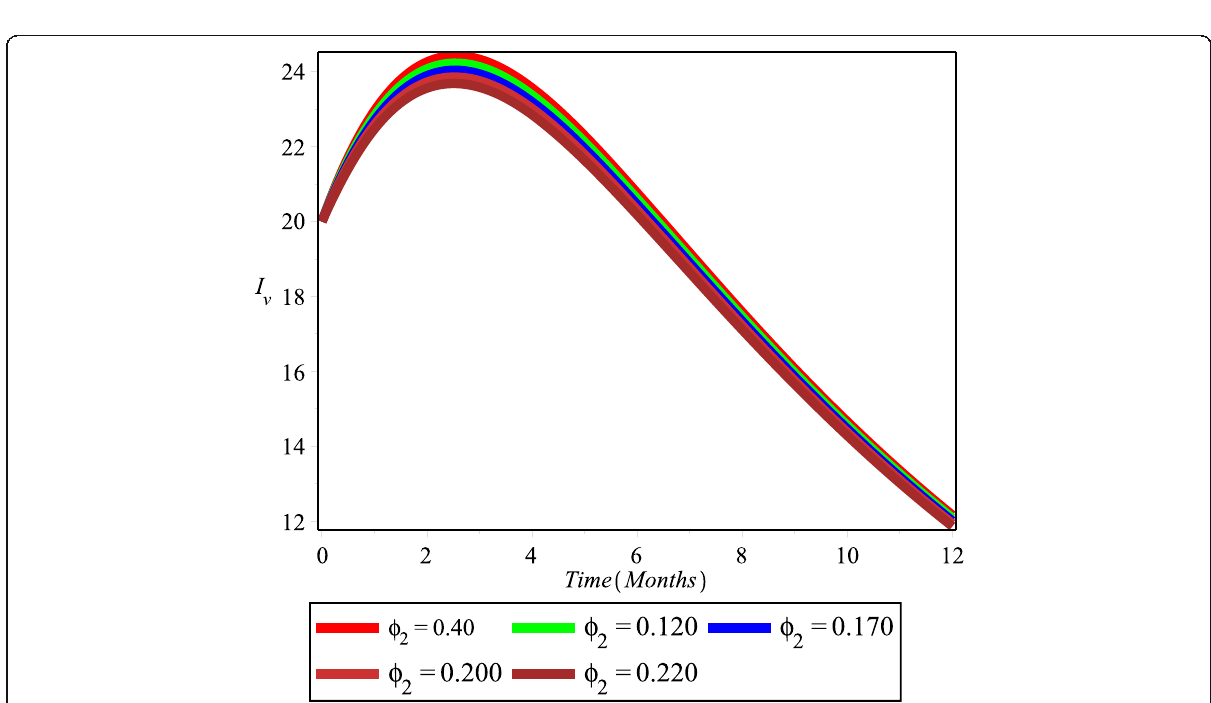
Fig. 9 Varying ϕ 1 (0.412 − 0.812) when R r >